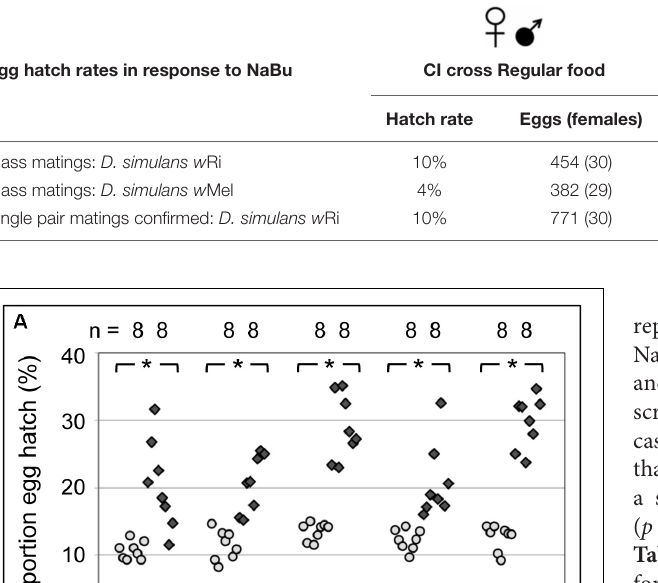
TABLE 2 | Egg hatch rates from CI-related crosses on NaBu treatment food.